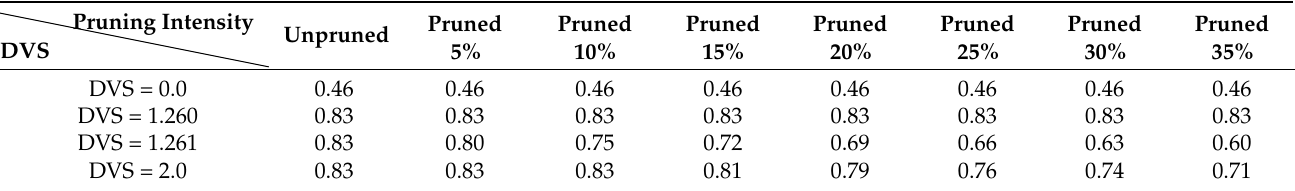
Table 1. Parameter configuration of KDIFTB at different developmental stages. (DVS: Develop- ment